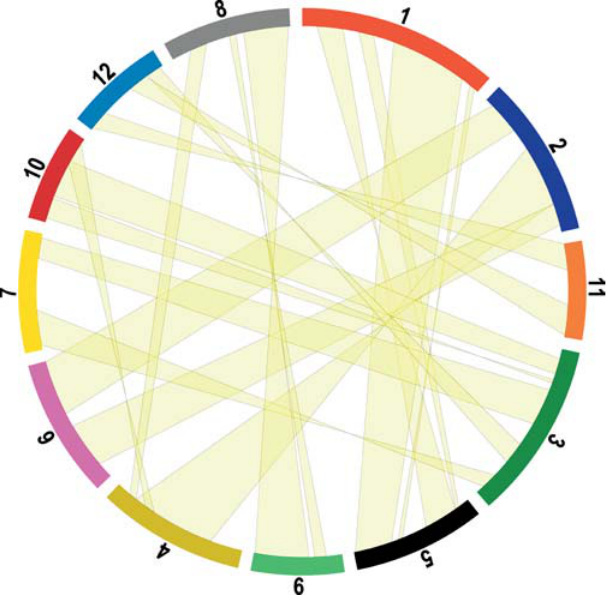
Figure 7. Graphical View of All Duplicated Segments The 12 chromosomes are depicted along the perimeter of a circle, not in order but slightly rearranged so as to untangle the connections between segments. Overall, we cover 65.7% of the genome. DOI: